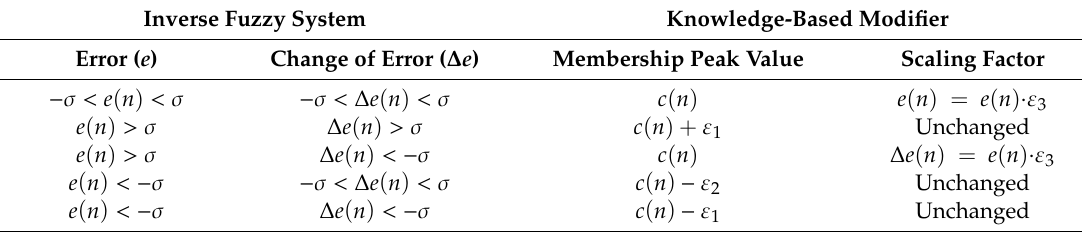
Table 3. Learning process of AFLC.